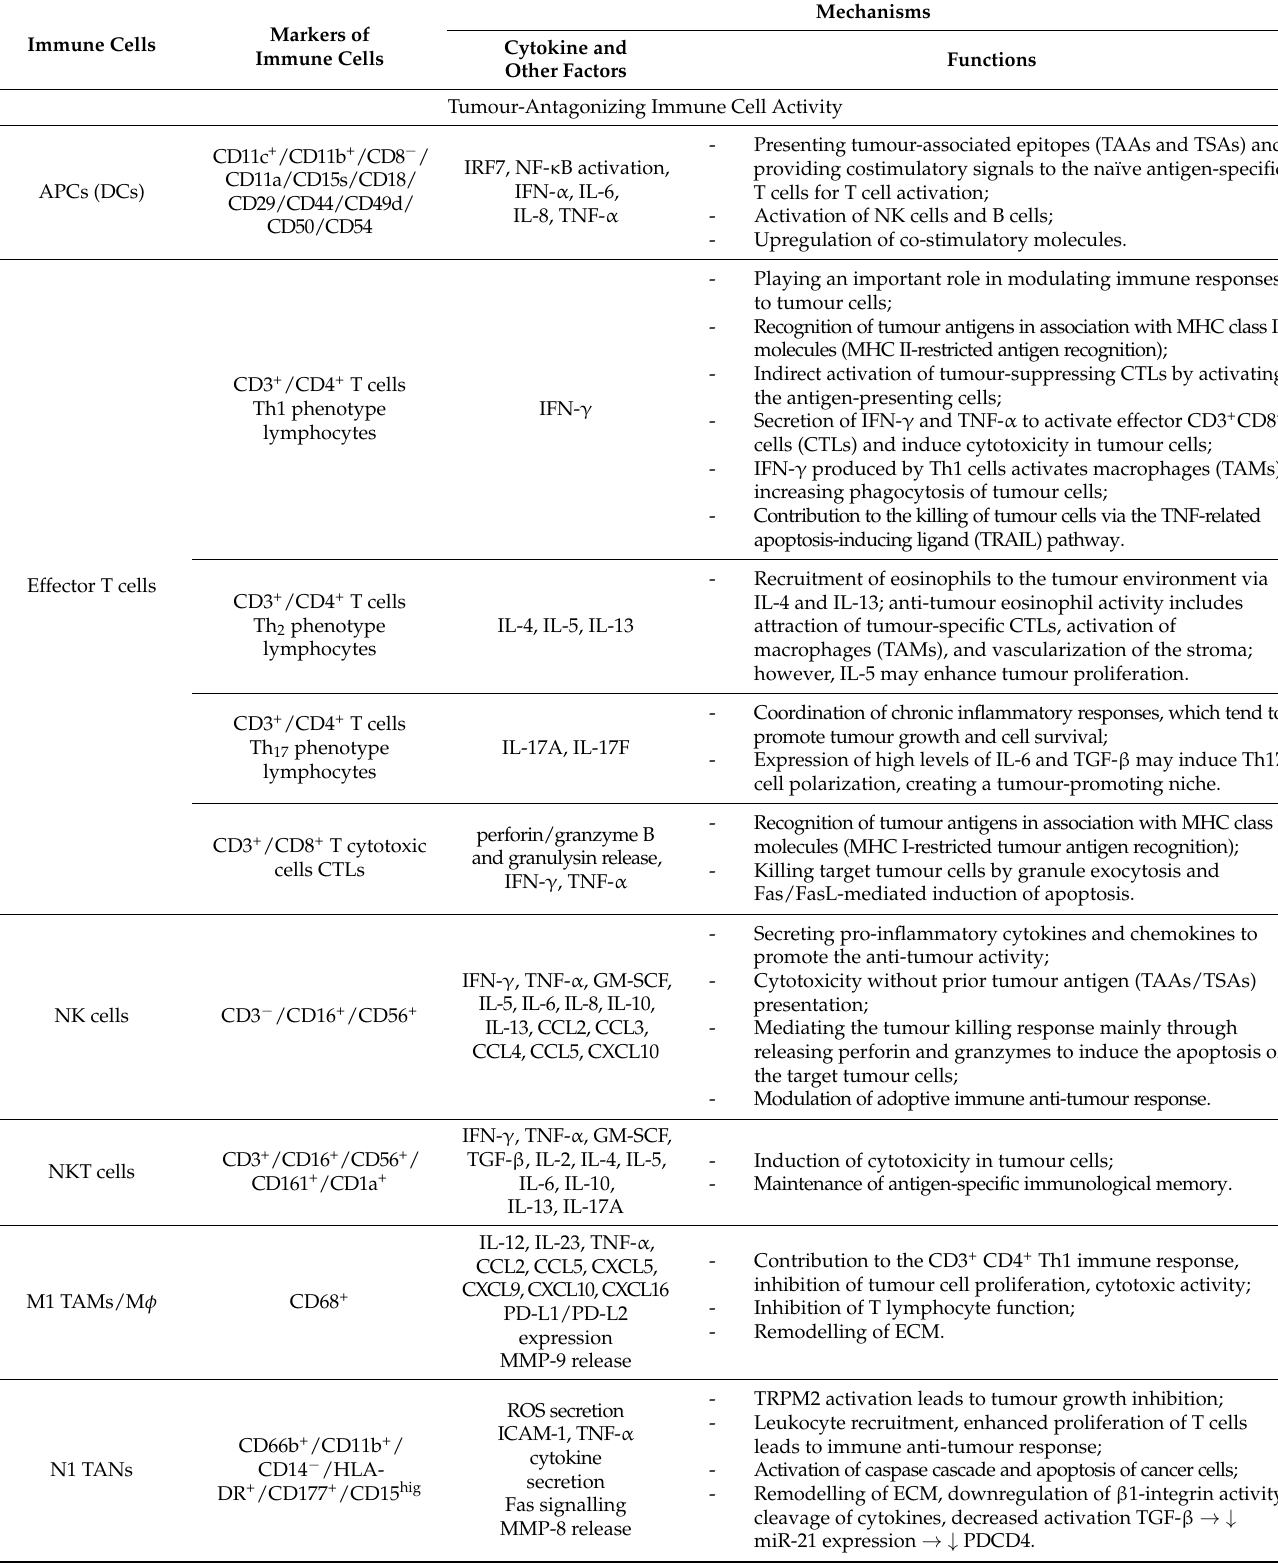
Table 1. Immune cell populations and their anti-tumour or pro-tumour functions within the